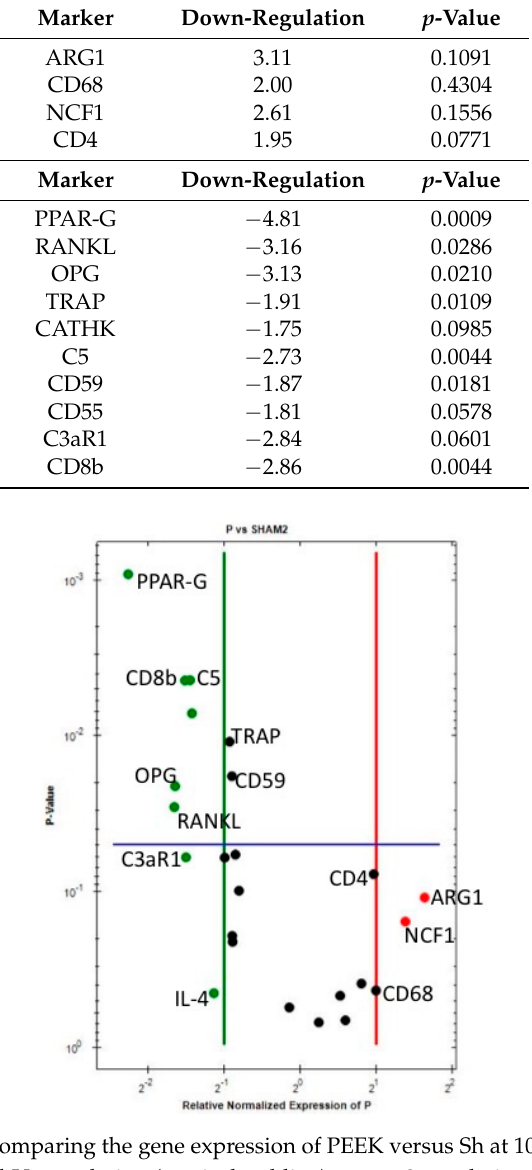
Figure 2. Volcano plot comparing the gene expression of PEEK versus Sh at 10 days. Downregulation (vertical green line) and Upregulation (vertical red line) set a × 2 regulation. Statistical significance (horizontal blue line) set at p < 0.05—Marker is significant when above blue line. Table 4. Gene expression PEEK vs. Sham.